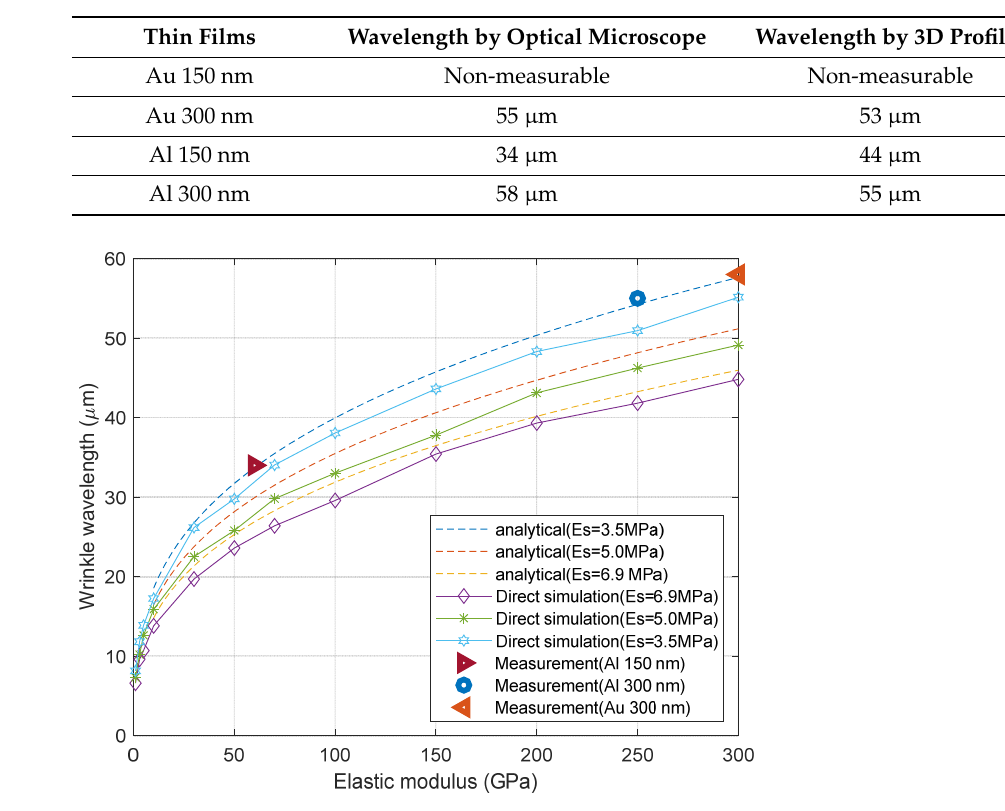
Figure 12. Elastic modulus extracted from wrinkling wavelength.